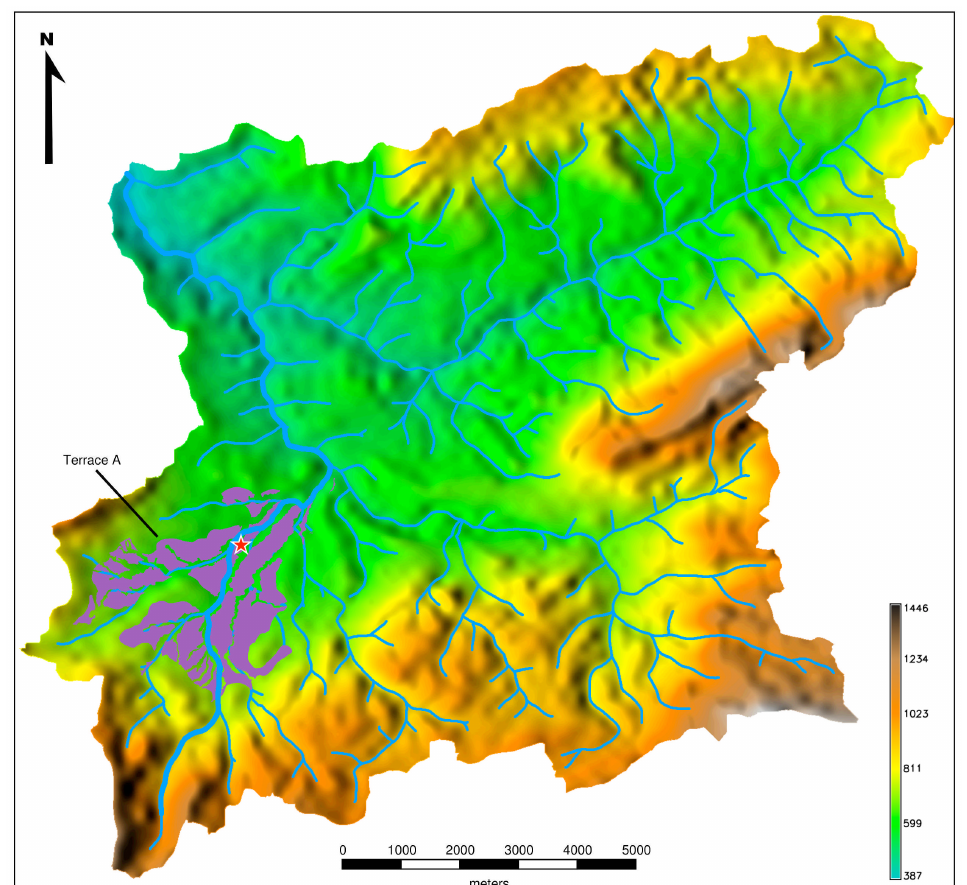
Figure 3. Reconstructed mid-Holocene topography in the Penaguila valley project area. The Neolithic site of Mas d’Is is shown, as are terraces near the site that are of Neolithic, or earlier, age (all labeled as “Terrace A”). The main watercourse passing by Mas d’Is is shown as a thick blue line, and the other portions of the extracted stream network are shown as thin blue lines. High elevations are shown in reds and brown, and lower elevations are shown in greens and